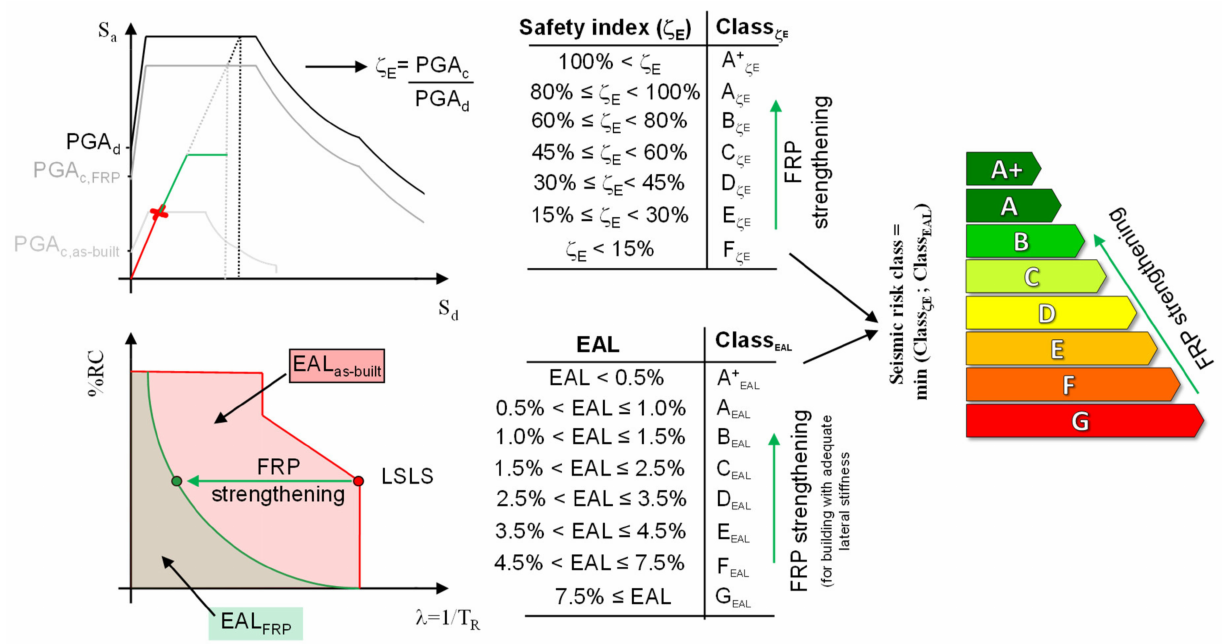
Figure 11. Impact of FRP-strengthening on the seismic-risk class, calculated based on Italian guidelines